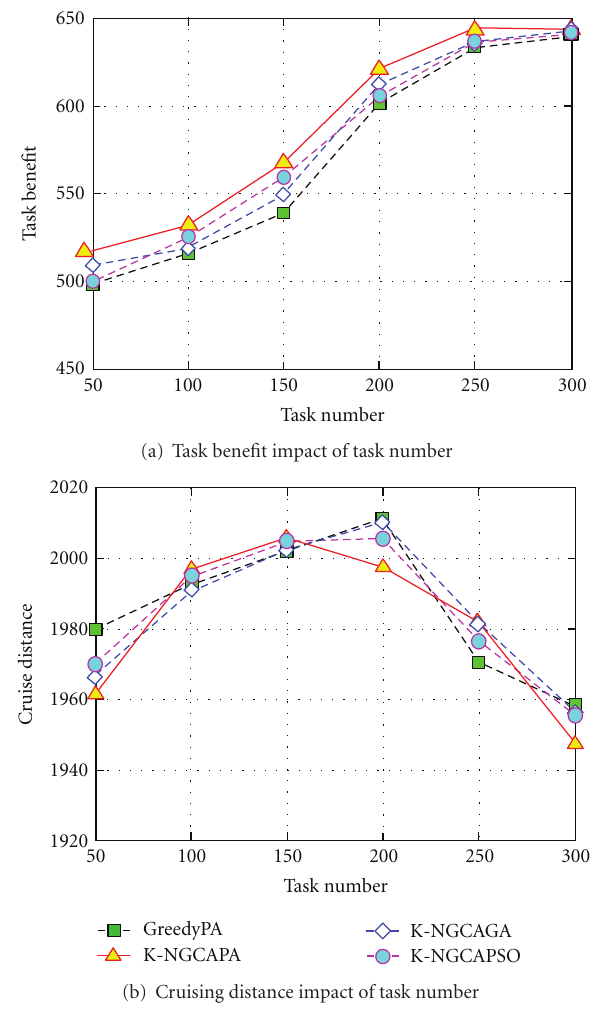
Figure 4: Scheduling results in various task